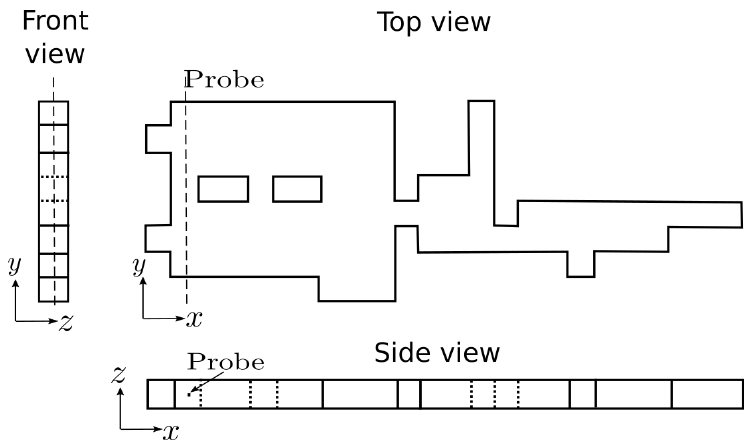
Figure 11. Probe